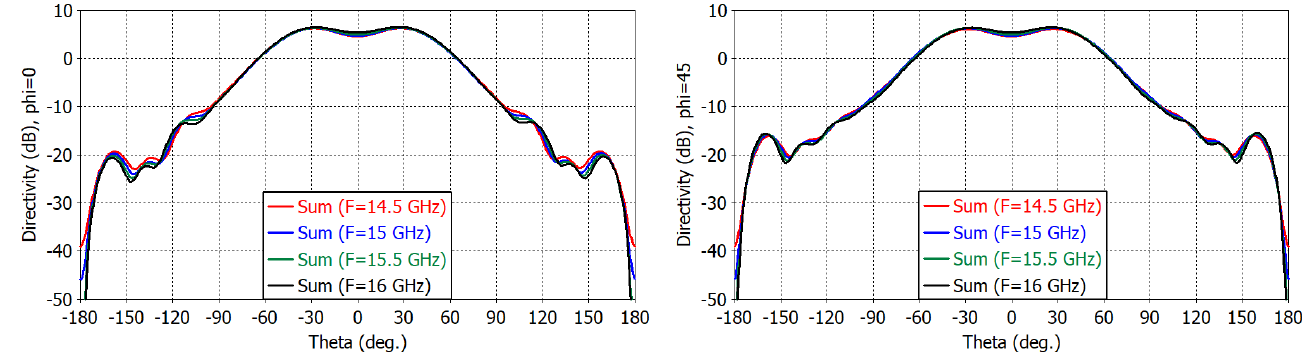
Figure 7. RHCP directivity patterns of the sum channel.